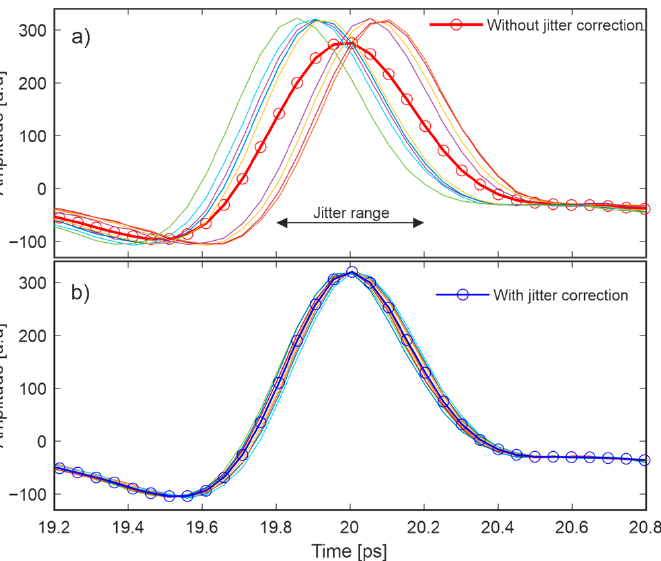
Figure 2. Ten waveforms and their averaging (line with circles) without ( a ) and with ( b ) jitter cor-